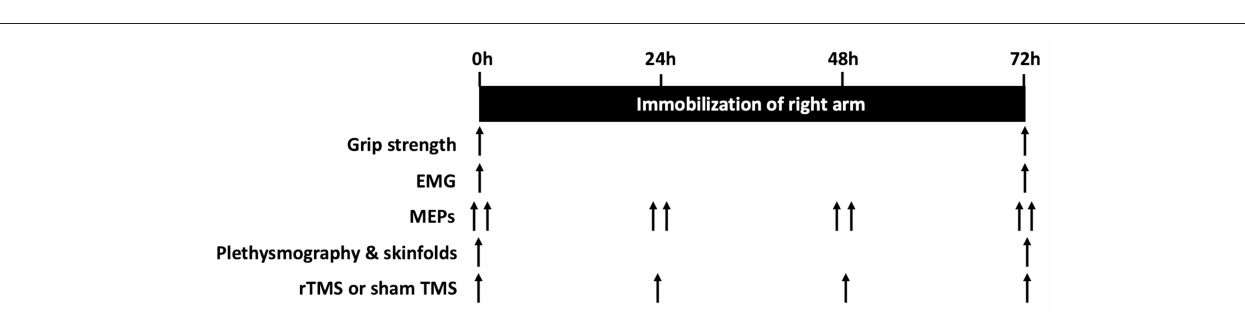
FIGURE 2 | Schematic of the experimental